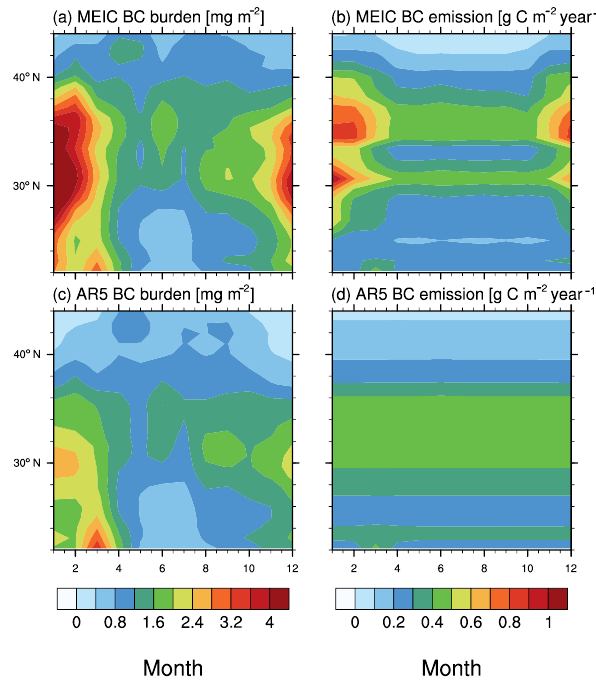
Figure 10. The seasonal variations of the longitudinal averages (100–124 ◦ E) of (a) burden of BC and (b) emission rate of BC using the MEIC emission, and (c) burden of BC and (d) emission rate of BC using the AR5 emission inventory over eastern China in